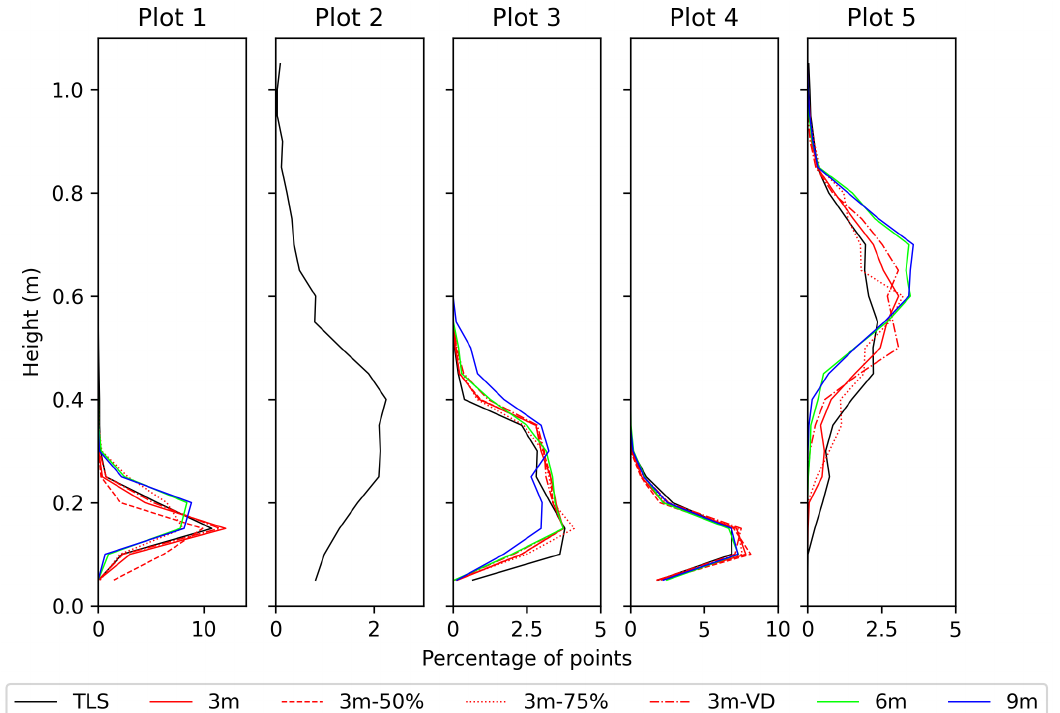
Figure 4. Height distributions of the terrestrial laser scanning (TLS) and image-based point clouds captured within the five plots. Distribution plots were created using 5cm vertical